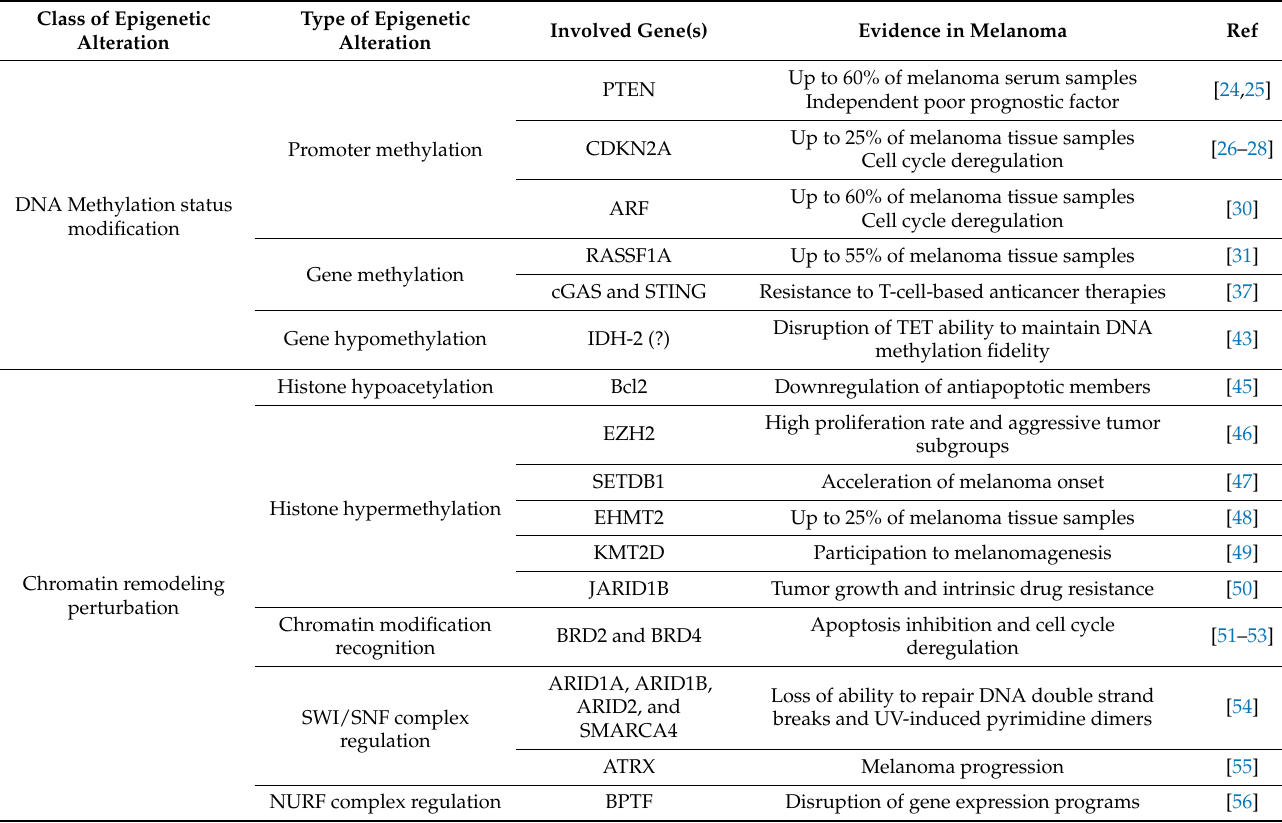
Table 1. Main epigenetic mechanisms altered in melanoma. Abbreviations: miRNA, micro-RNA; lncRNA, long non- coding